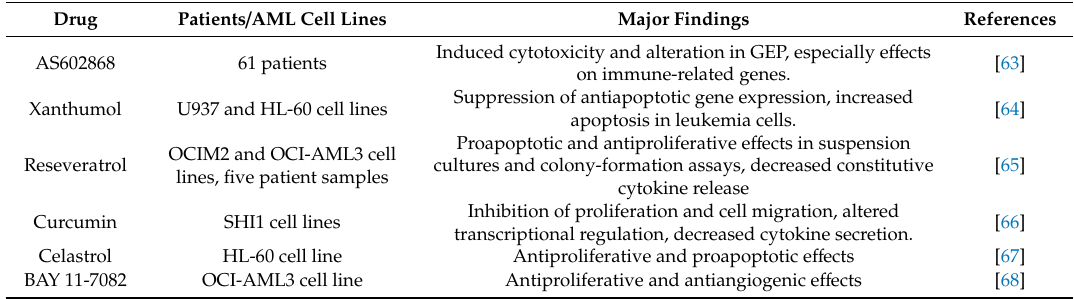
Table 2. Summary of important in vitro studies of NF- κ B inhibition in AML.